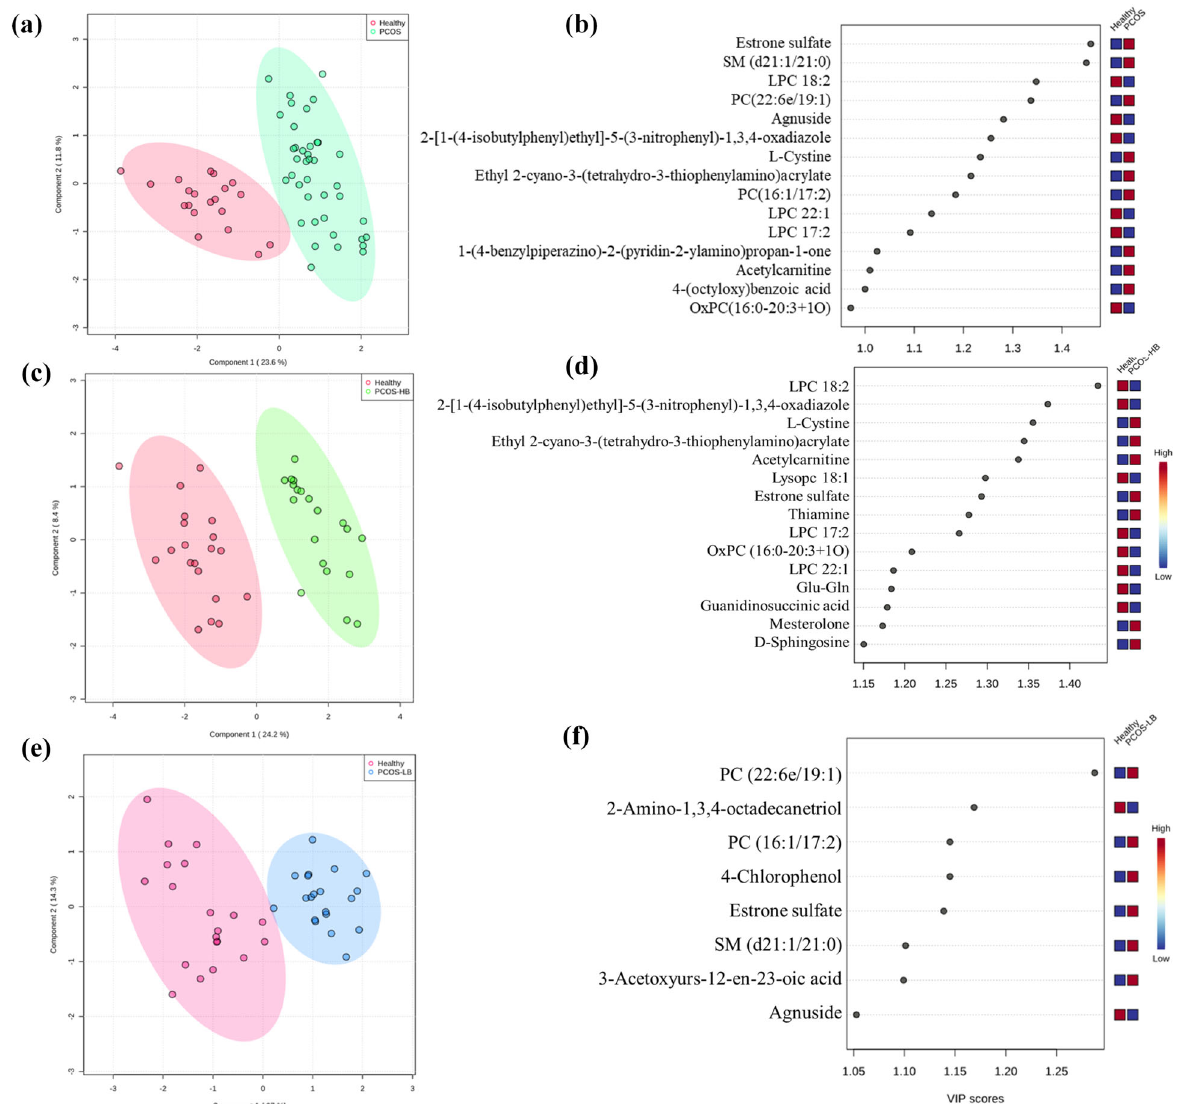
Fig. 3 Comparison of pairwise metabolite pro fi le characteristics. a The PLS-DA plot showing the distribution pattern difference between healthy patients and patients with PCOS. b VIP scores of PLS-DA in comparison between healthy patients and patients with PCOS. c The PLS- DA plot showing the distribution pattern difference between healthy patients and patients with PCOS-HB. d VIP scores of PLS-DA in comparison between healthy patients and patients with PCOS-HB. e The PLS-DA plot showing the distribution pattern difference between healthy patients and patients with PCOS-LB. f VIP scores of PLS-DA in comparison between healthy patients and patients with PCOS-LB. VIP scores were used to rank the discriminating power of different taxa between the PCOS and control groups. A taxon with a VIP score of >1 was considered important in the discrimination. Red, green, and blue color represent Healthy, PCOS-HB and PCOS-LB group